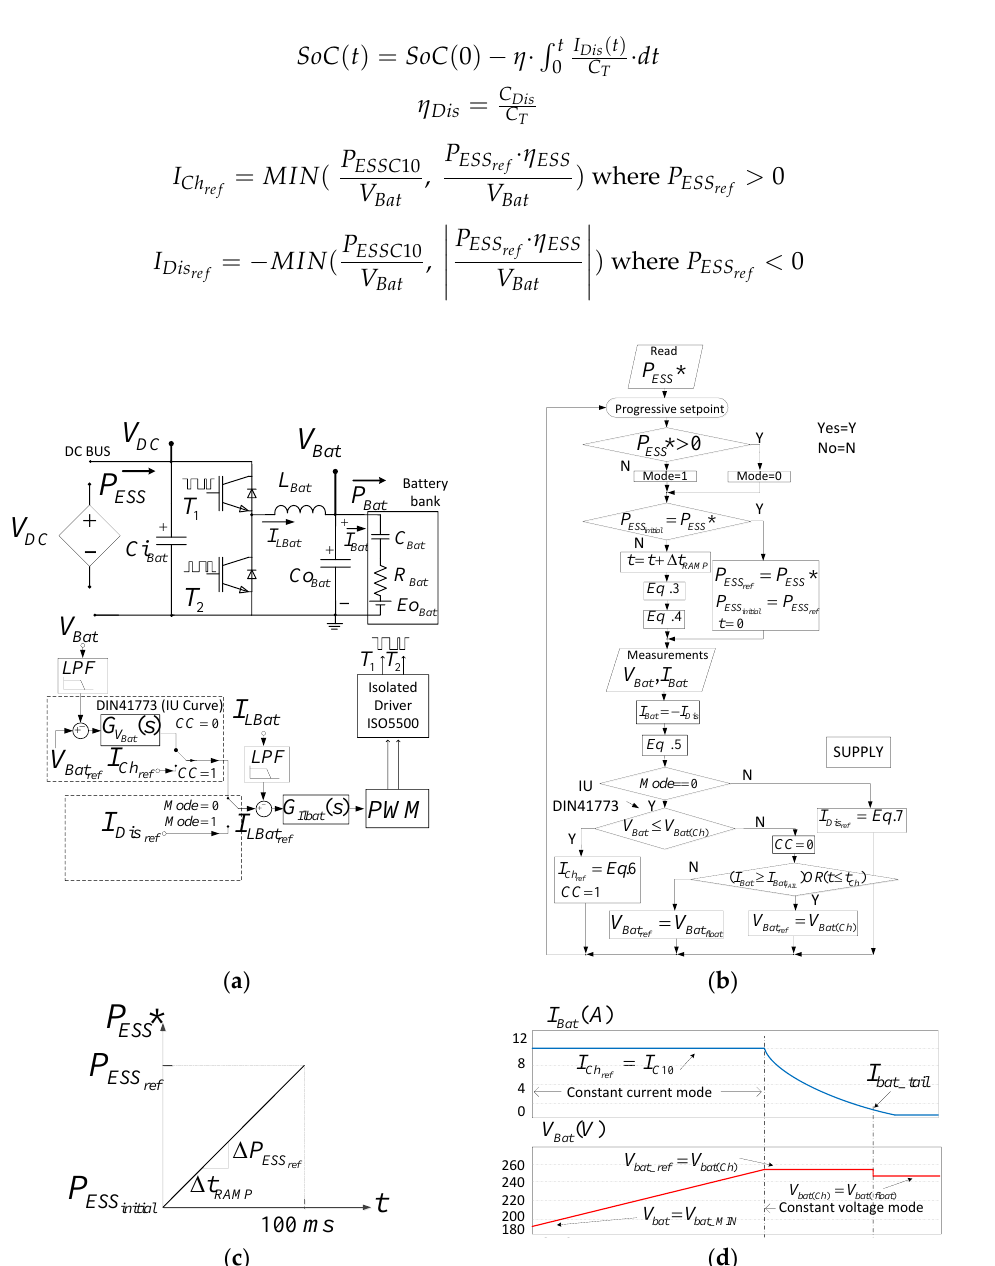
Figure 3. Topology and control of the ESS: ( a ) Half-bridge DC/DC converter; ( b ) Proposed battery charging/discharging control algorithm; ( c ) Ramp function; ( d ) DIN 41773 (IU curve). Table 2. Characteristics of the